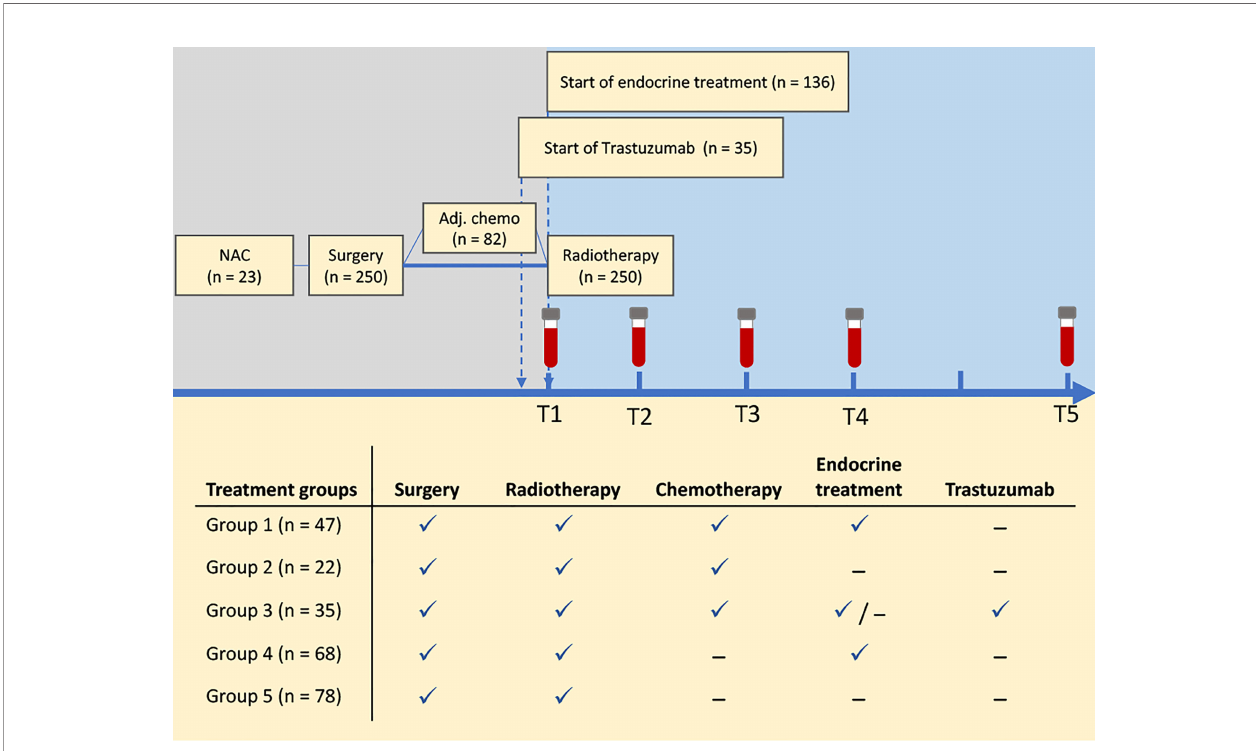
FIGURE 1 | Study overview. Patients were treated according to national guidelines at the time of inclusion. Serum samples were collected at fi ve time points before and after radiation treatment, and follow-up data on recurrence and survival were collected after 10 years. Patients were categorized into fi ve treatment groups for assessment of treatment-related changes in serum metabolite and lipoprotein pro fi les. NAC, neoadjuvant